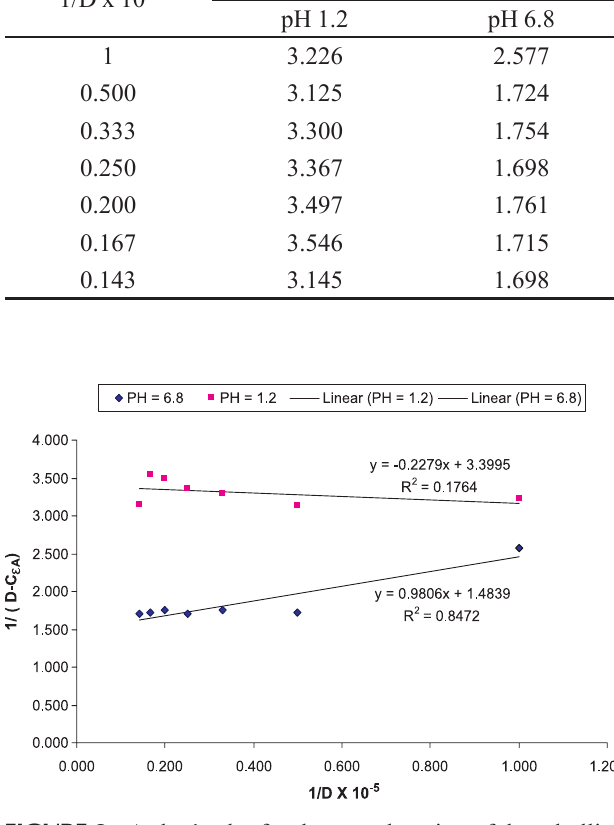
FIGURE 3 - Ardon’s plot for the complexation of theophylline with ketotifen at 300 nm. TABLE V - Stability constant of theophylline with ketotifen at